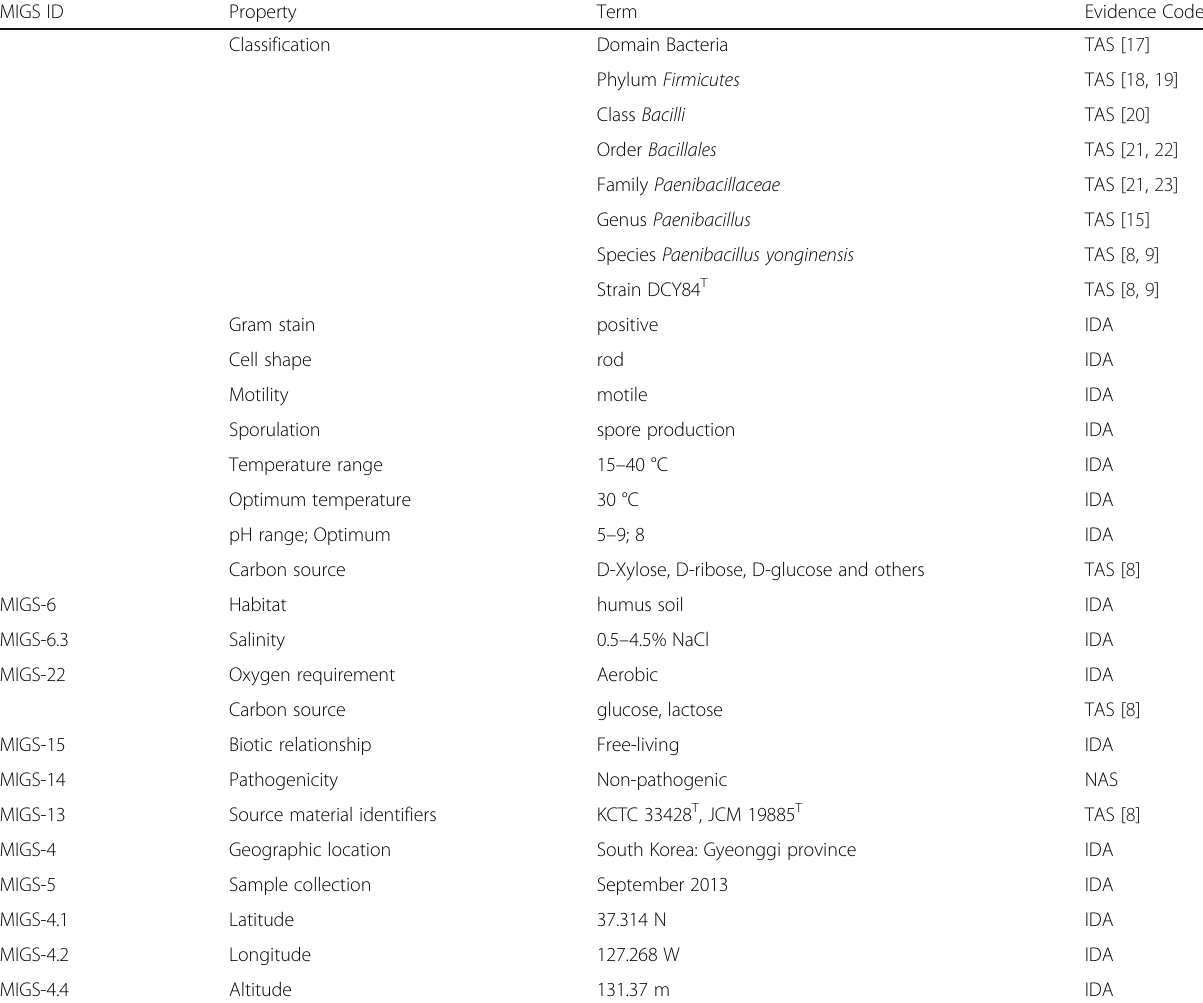
Table 1 Classification and general features of Paenibacillus yonginensis DCY84 T MIGS